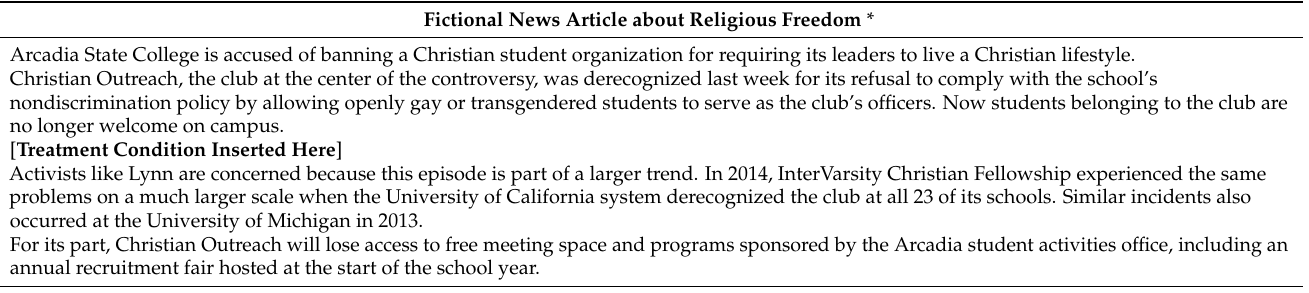
Table 2. Summary of experimental